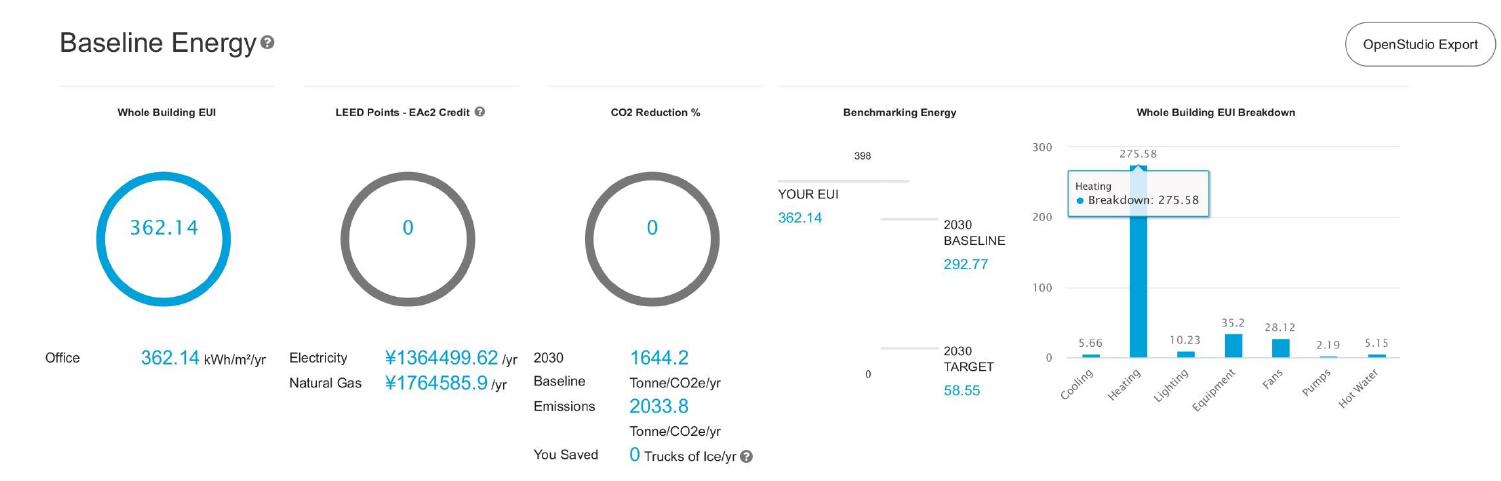
Figure A18. Zone 4-B Beijing, Beijing (post-COVID-19 84% scenario).